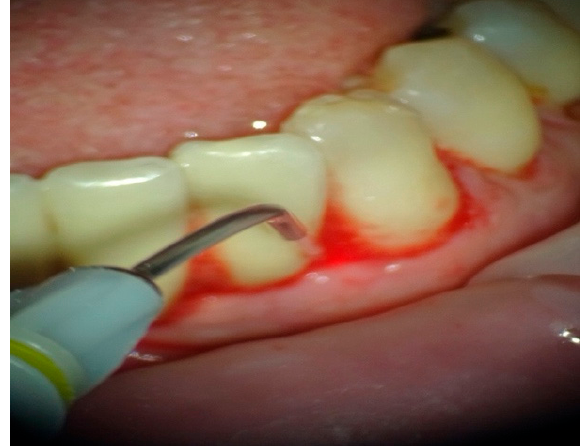
Figure 4. Treatment with a Wiser diode laser with a peak power of 2.5 W, T-On of 20 microns, T- Off of 80 microns, average power of 0.5 W, duty cycle of 100 microns and frequency of 10